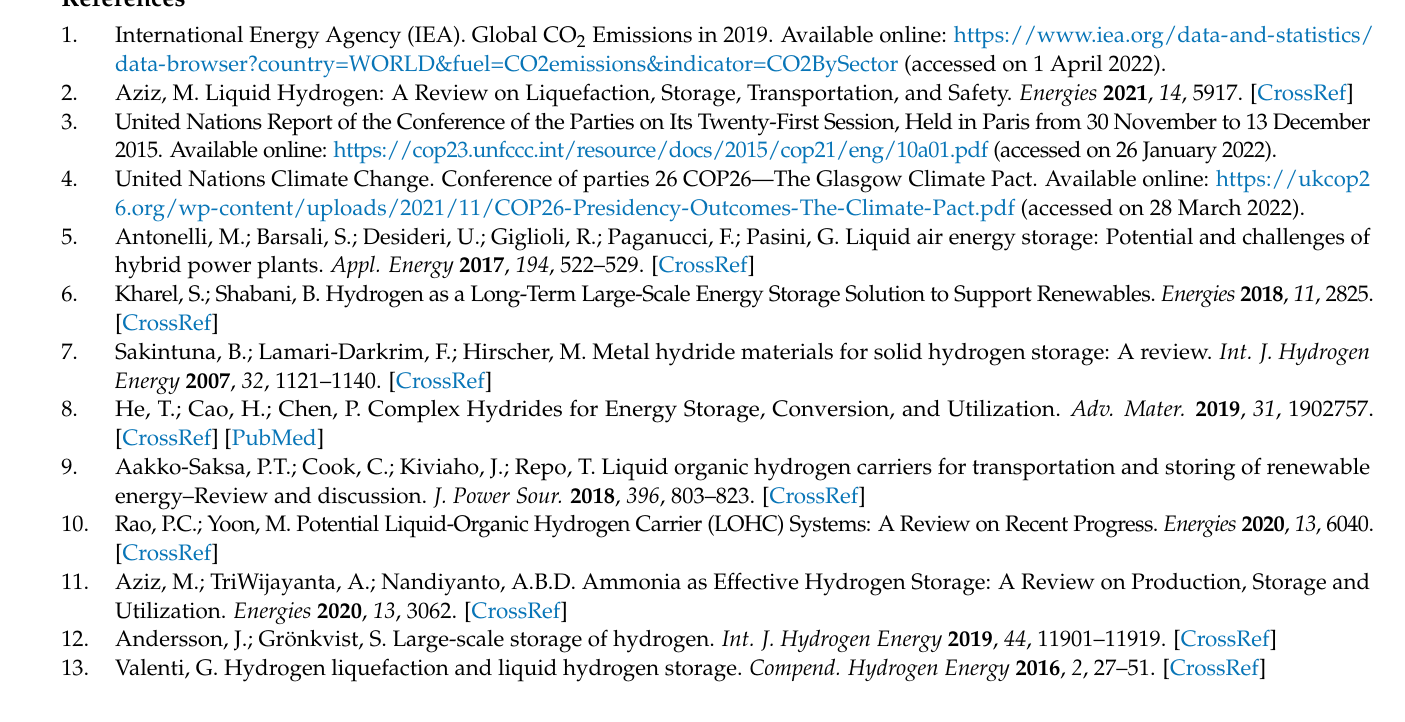
Table S1: Individual results of each hydrogen sample taken from the hydrogen liquefication